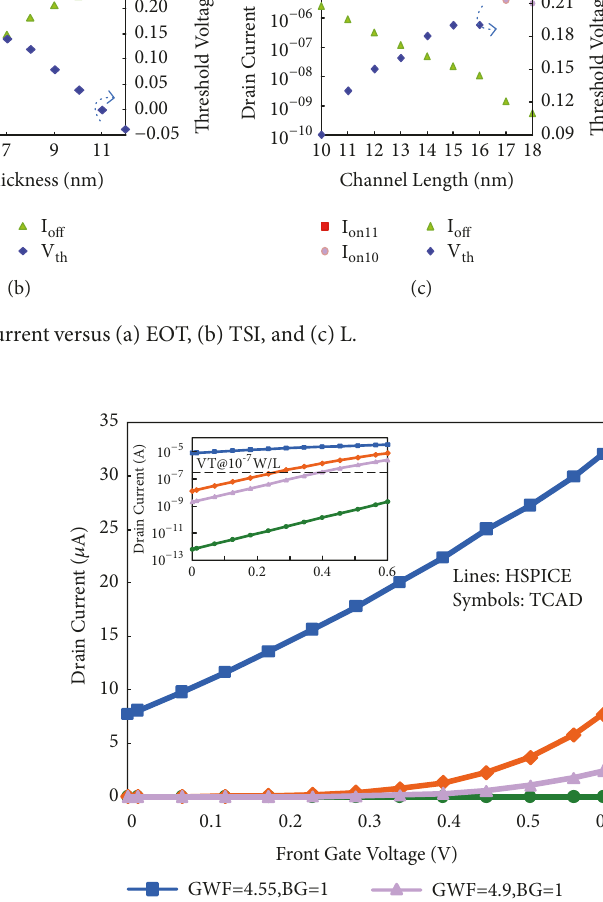
Figure 5: Thecurrentcharacteristicresultsof N-typeDTIG FinFET from Sentaurus Device and HSPICE.